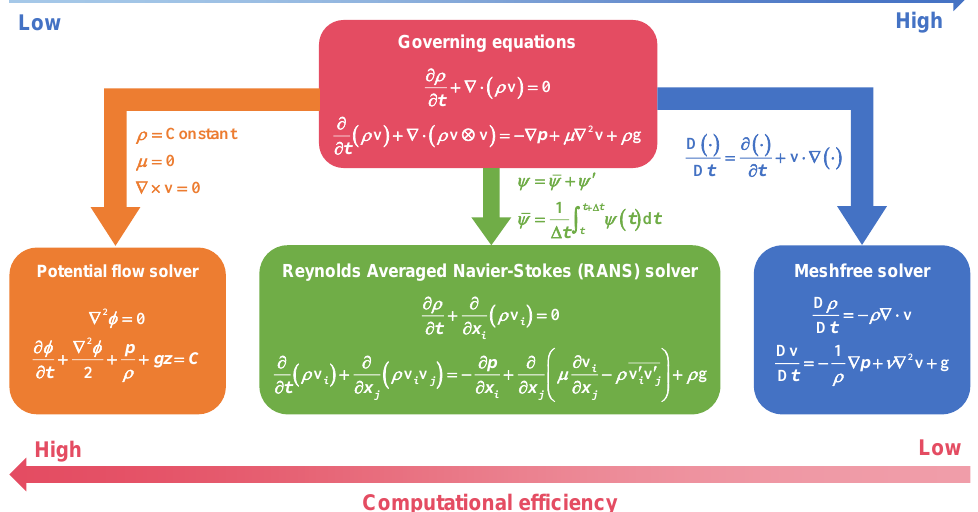
Figure 3. A brief comparison of the most popular numerical methods for simulating OEDs. For more details regarding these governing equations, the readers can refer to the textbooks